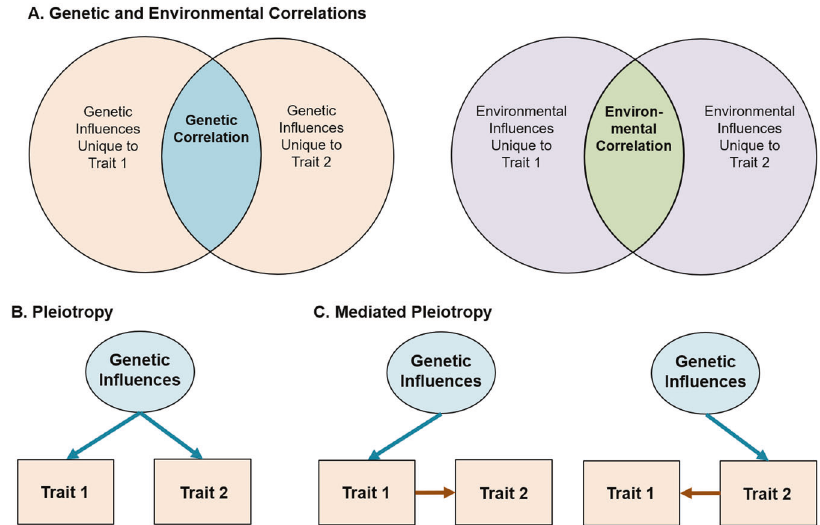
Fig. 3 Guide for interpretation of genetic and environmental correlations. Variance in any given trait is explained by a combination of genetic in fl uences (i.e., heritability) and environmental in fl uences. For complex traits (e.g., MDD or depression symptoms), cognitive abilities (e.g., intelligence), and personality traits (e.g., impulsivity), many hundreds or thousands of independent genetic effects are combined together in the total heritability estimate. Similarly, environmental in fl uences typically represent a multitude of factors, from individual life events to speci fi c exposures (e.g., chemicals, etc.). The presence of a genetic or environmental correlation between traits indicates that some set of these in fl uences have an impact on multiple traits. A Displayed using a Venn diagram. Identifying the strength of genetic vs. environmental correlations can be useful in testing theoretical models and pave the way for more complex genetic investigations. Beyond this, gene identi fi cation efforts (e.g., genome-wide association studies) and additional analyses of the resulting data can be used to classify whether these associations represent speci fi c genetic in fl uences that affect both traits equally (i.e., genetic pleiotropy ( B )) or whether a genetic in fl uence impacts only one trait which in turn causes changes in the other (i.e., mediated genetic pleiotropy ( C )). Environmental in fl uences can also act pleiotropically or in a mediated-pleiotropy manner, but only genetic in fl uences are displayed for simplicity. Translational Psychiatry (2021)